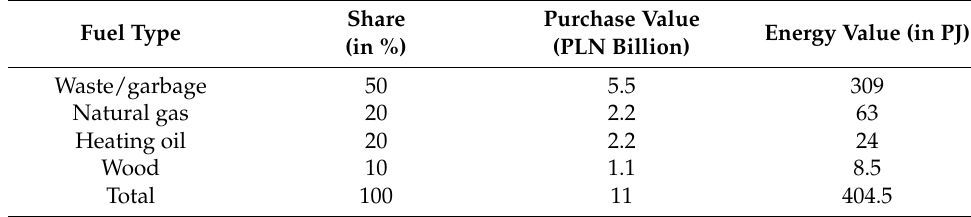
Figure 4. Scenario 6—energy value of the assumed mix of alternative fuels. Source: own study. Table 3. Estimation of the energy value for scenario 6.